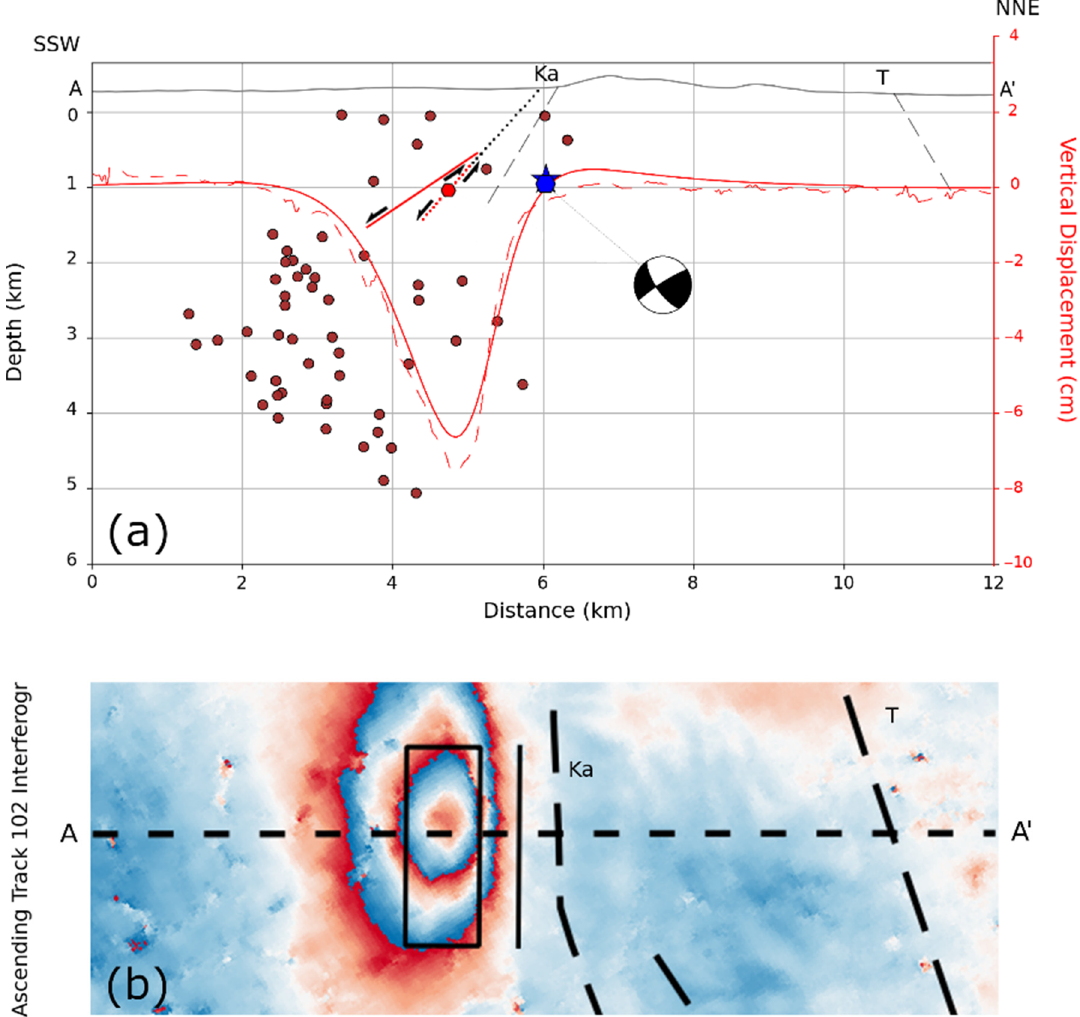
Figure 7. ( a ) Cross-section perpendicular to the inferred rupture plane, striking N120°E (trace of A–A’ in Figure 5), with the hypocentral distribution of the mainshock (star), aftershocks (circles) and seismic centroid (blue polygon). The inferred fault for dip angle at 33° (favored by seismology) and 48° (favored by geodesy) are plotted by solid and dashed red line, respectively. The red polygon is the geodetic centroid. The red solid curve is the vertical component of the model with dip angle favored by geodesy and the dashed one is the measurement (Figure 3). ( b ) The ascending interferogram rotated to the same orientation as the cross section, the projection of the inferred fault (its dip favored by geodesy) and with A–A’ the cross-section line. Faults (black lines) and their names as in Figure 5. The focal mechanism is projected to the cross-section plane.